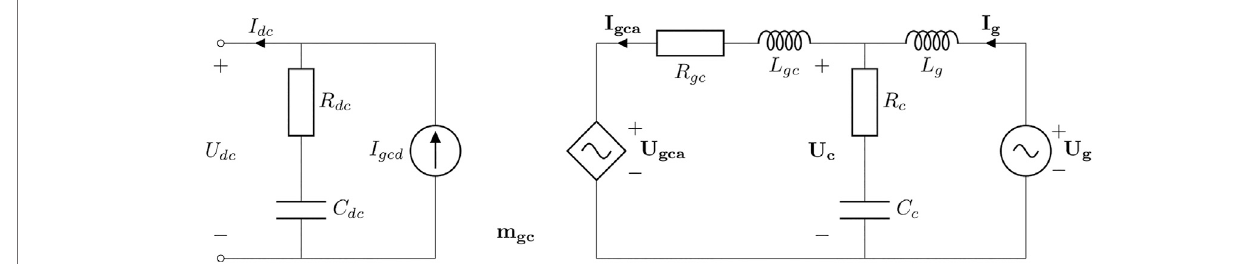
FIGURE 4 | Schematic representation of the dc link and the grid converter and its LC fi